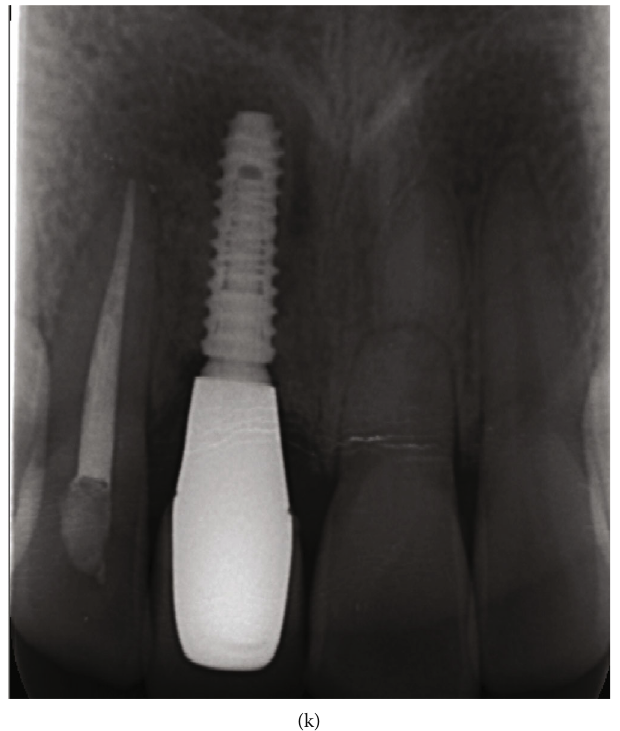
Figure 3: Case 2: (a) Preliminary Cone-beam CT before implant placement. (b) A coronal image of site #11 indicated the absence of labial bone and poor socket healing. (c) Fistulas were observed in the labial mucosa around implant #11(red arrow). (d, e) Follow-up visit after implant placement for 5 months, radiography appeared to indicate a mesial spread of apical periodontitis in tooth #12 to the coronal peri-implant defect (red arrow). (f) Apical radiograph revealed a diagnostic Gutta-percha cone tracing from mucosal fi stulas to tooth #12 (red arrow). (g) Periapical radiographs at 1-month follow-up after fi lling the root canal with Vitapex. (h) Cone-beam CT indicated that RCT of tooth #12 was suitable, and the peri-implant bone defect was healed after half a year. (i) Intraoral photographs half a year after root canal fi lling. (j) The intraoral photograph of the implant-supported restoration 7 months after RCT showed healthy peri-implant mucosa. (k) Apical radiograph showed no defects of peri-implant supporting bone. Root canal therapy, RCT.